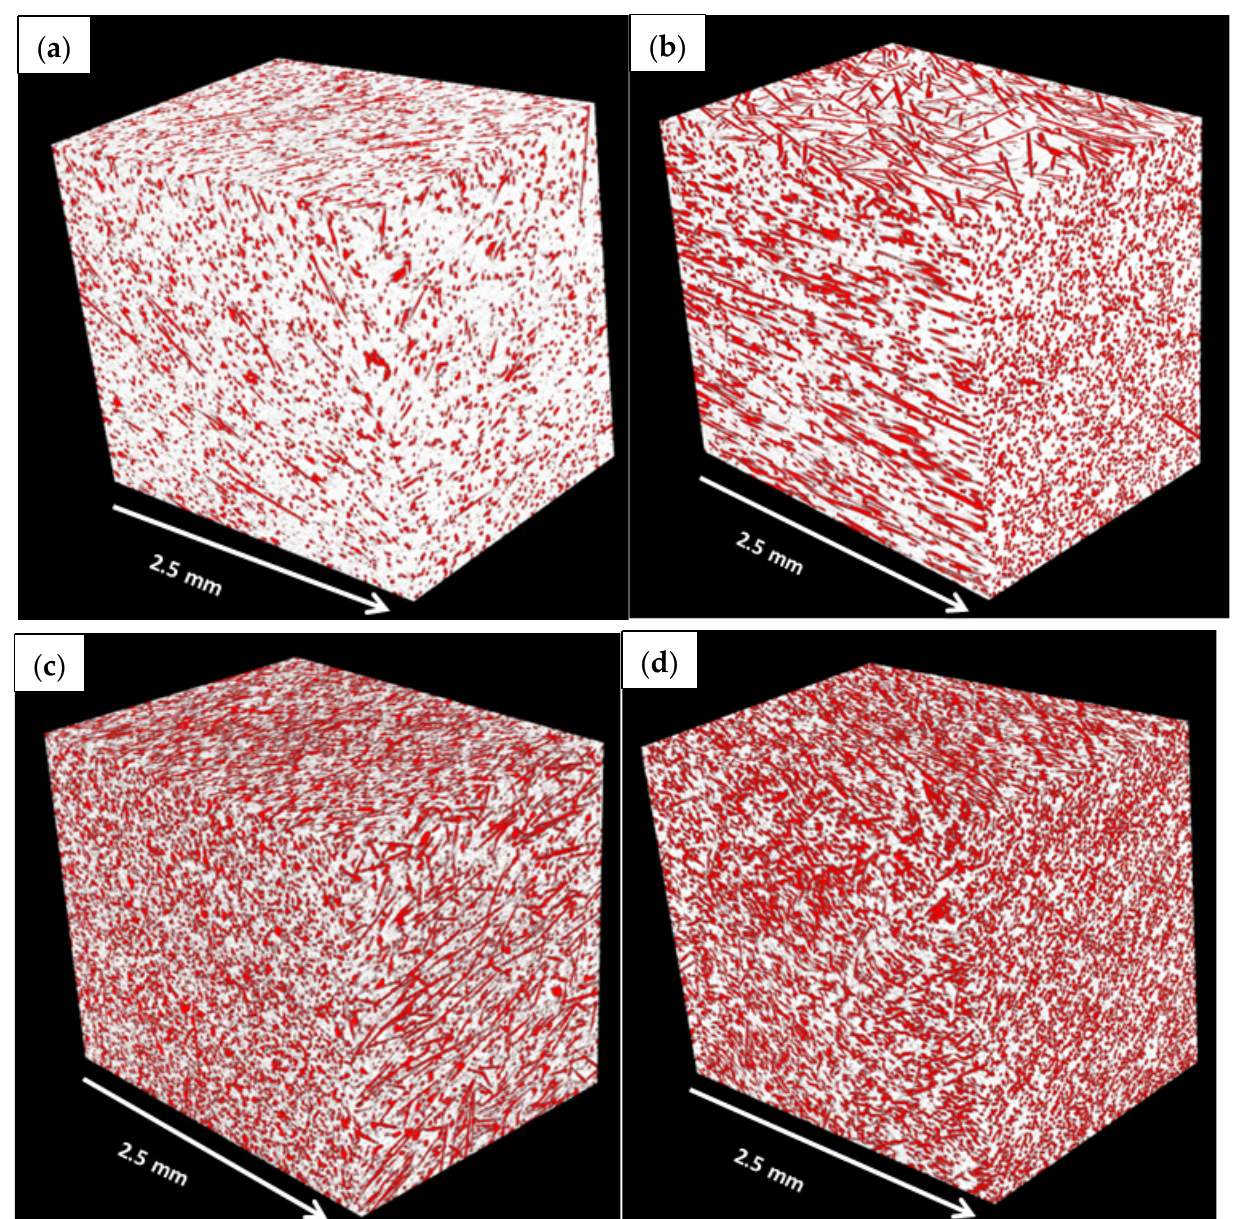
Figure 13. Tomogram images 3D visualisations of the central part of the plain thermoplastic sam- ples; each subset represents roughly one-third of the samples’ volumes imaged; (( a ): PA625GF, ( b ): PA625GF+5MoS 2 , ( c ): PA633GF, and ( d ): PA650GF).